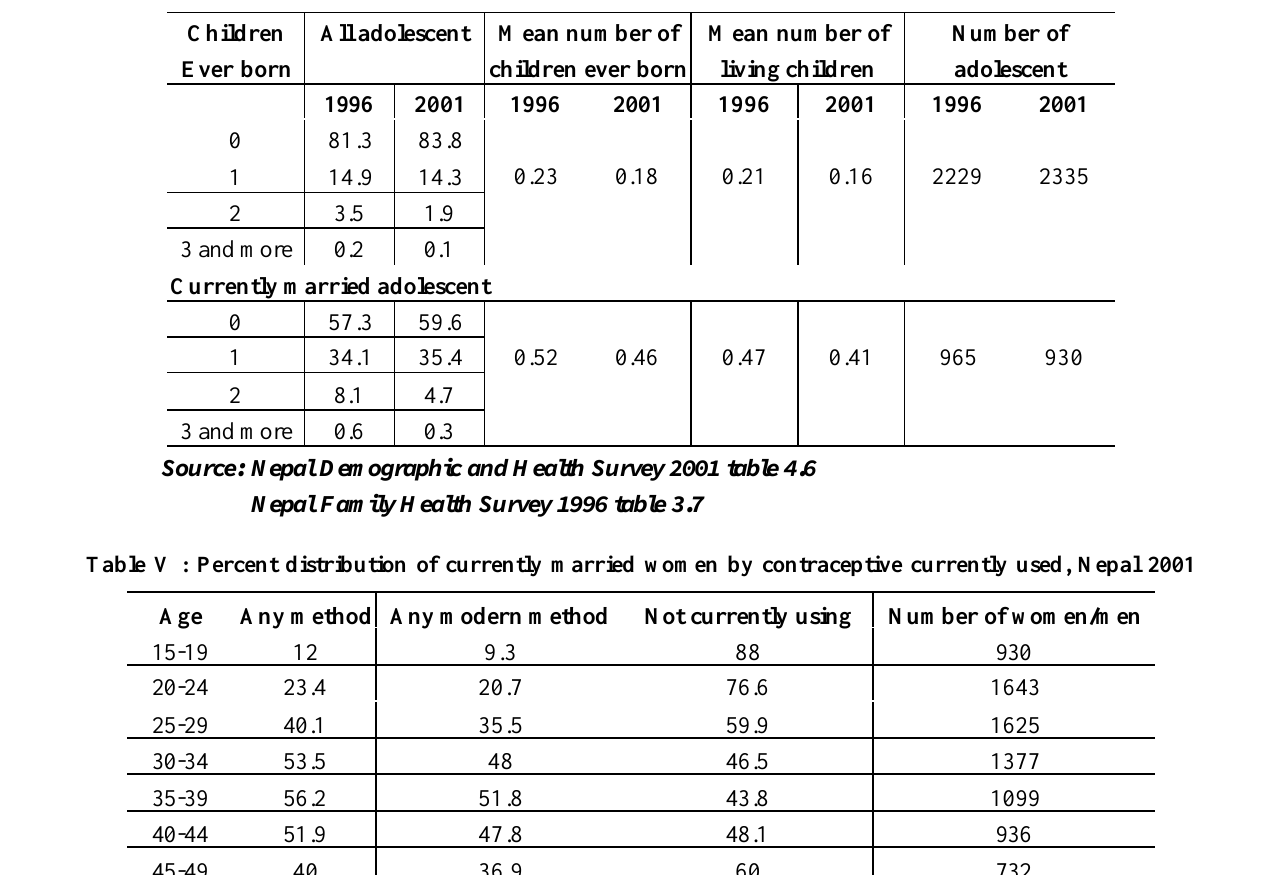
Source: Nepal Demographic and Health Survey 2001 part of the table